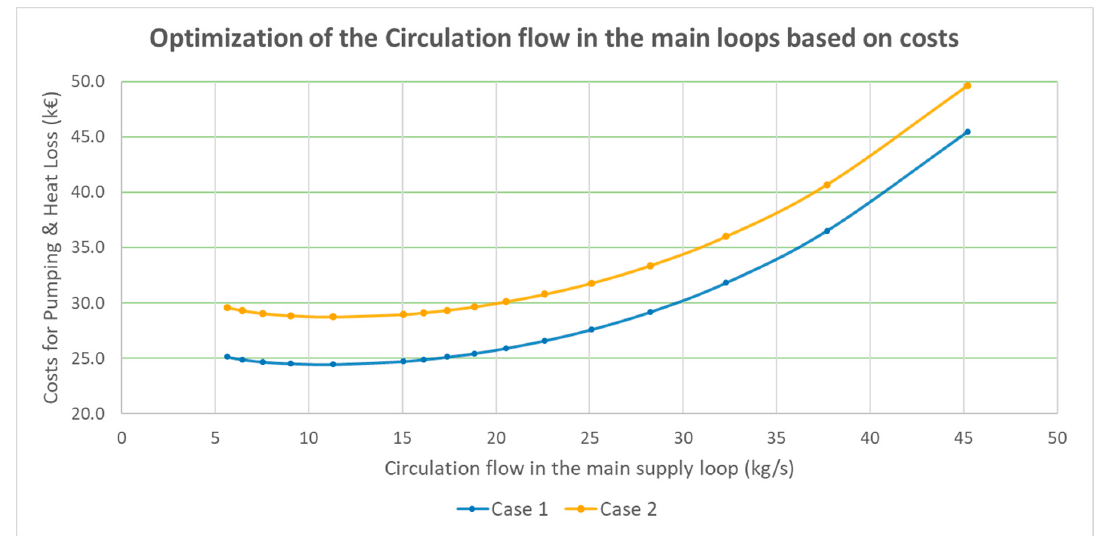
Figure 11. Optimal summer circulation flow in the main supply loop.